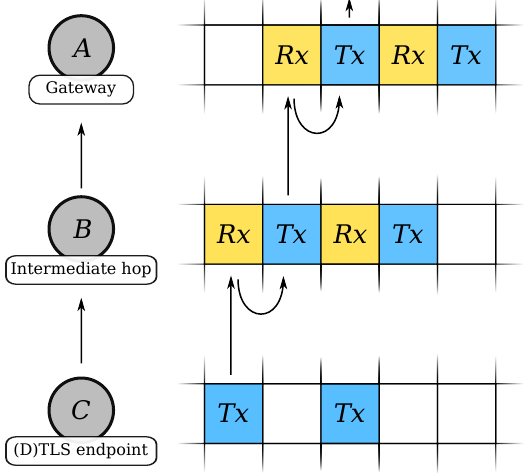
Figure 11. Slots are allocated in an interleaved, continuous manner to build a tunnel from the (D)TLS endpoint (C) over the intermediate hop (B) to the gateway